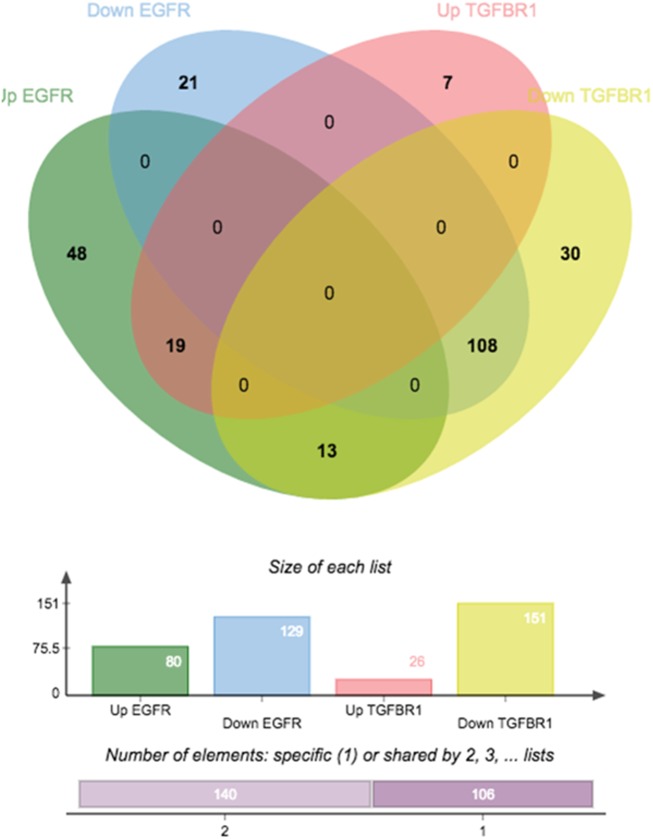
Depicted is the Venn diagram showing the genes up and down regulated by each of the transactivation dependent signalling pathways.209 genes are differentially expressed via thrombin transactivation of the EGFR (80 upregulated and 129 down regulated) and 177 genes are differentially expressed via thrombin transactivation of the TGFBR1 (26 upregulated and 141 down regulated).